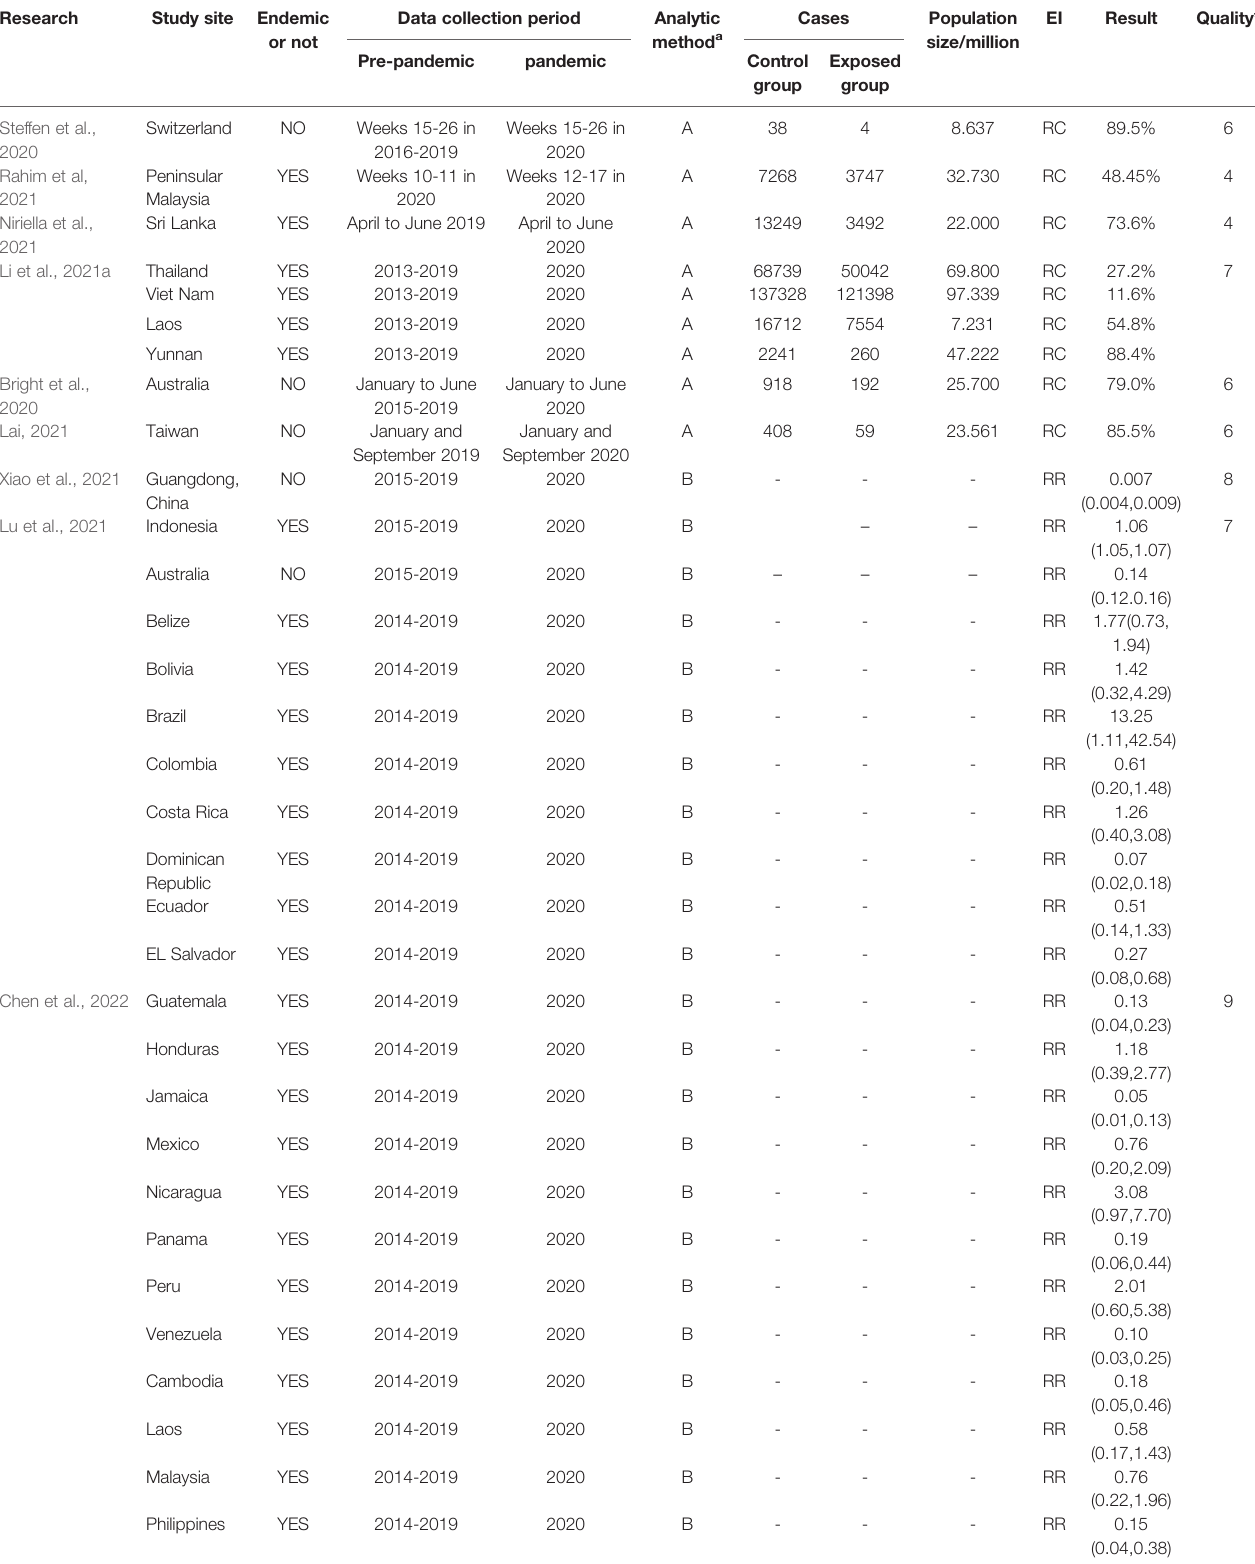
TABLE 1 | Characteristics of studies included in the systematic review and